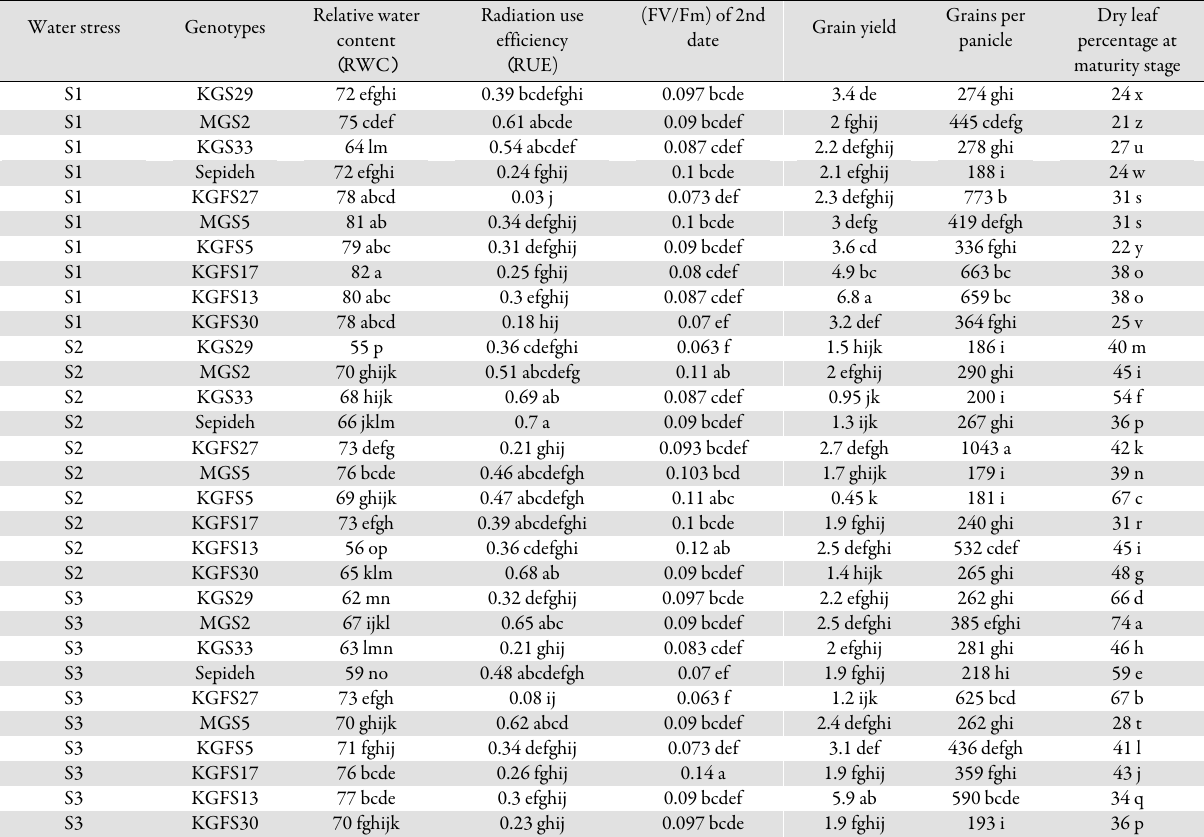
Table 3. Mean comparison of the effect of different level of water stress and genotypes on physiological characteristics in grain sorghum